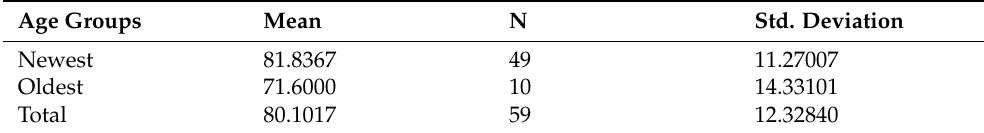
Table 4. Ageism score and age group statistics .